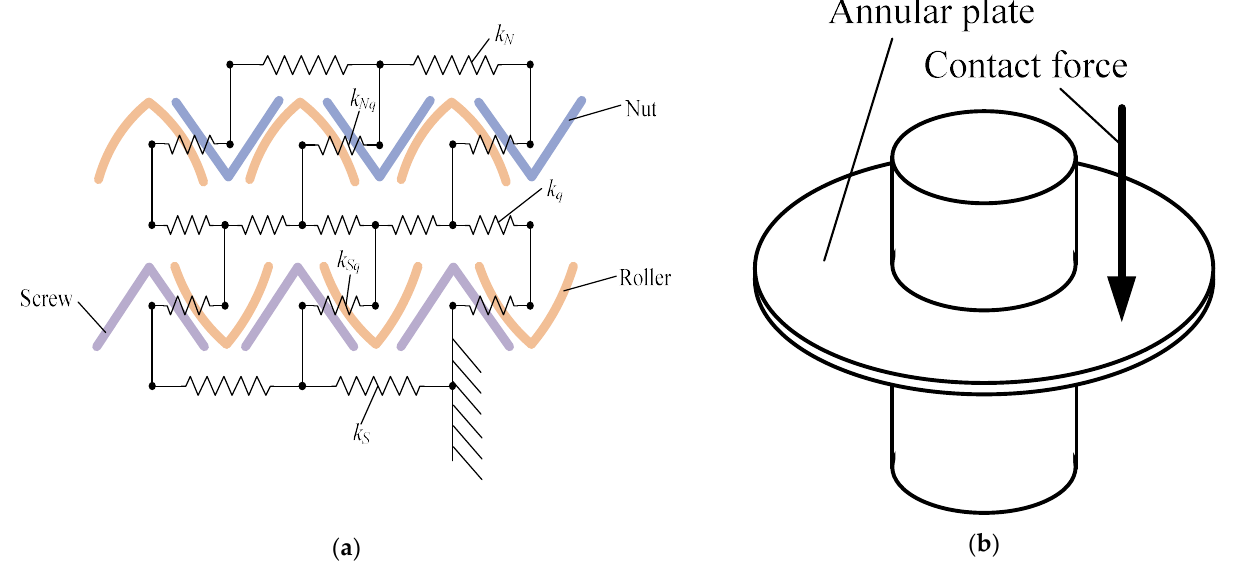
Figure 10. ( a ) Spring network diagram for non-preloaded PRSM; ( b ) annular plate with a contact force acting on a point in Ref. [48].